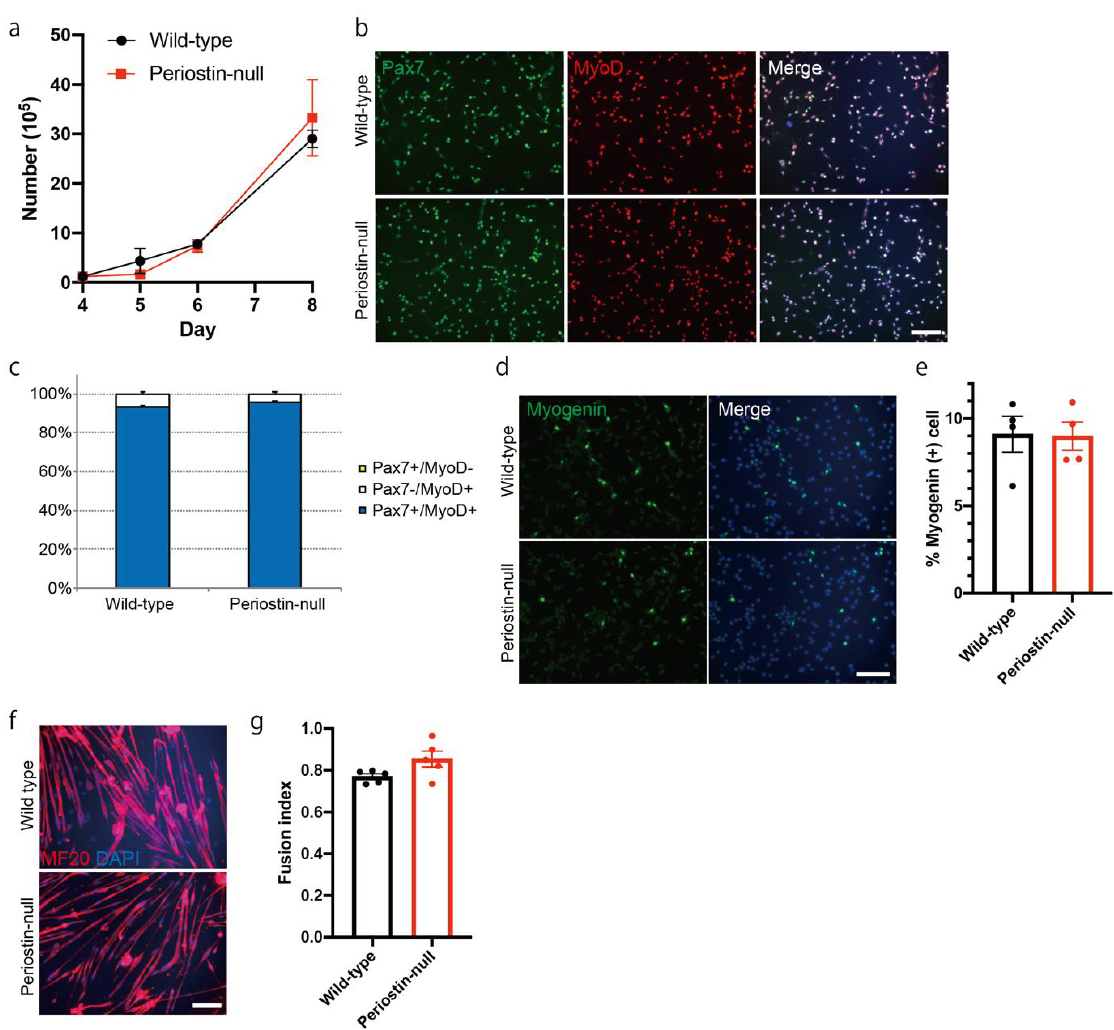
Figure 6. Proliferation and differentiation of muscle progenitor cells are not impaired in periostin-null mice. ( a ) Time- course changes in the number of cultured muscle progenitor cells. n = 4. ( b ) Immunocytochemical analysis of Pax7 and MyoD in muscle progenitor cells from periostin-null mice. Bar: 200 μm. ( c ) Ratio of Pax7+/MyoD-, Pax7-/MyoD+, and Pax7+/MyoD+ cells. n = 4. ( d ) Immunocytochemical analysis of myogenin in muscle progenitor cells from periostin-null mice. Bar: 200 μm. ( e ) Quantitative analysis of myogenin-positive cells. n = 4. ( f ) Immunocytochemical analysis of MF-20 in differentiated muscle progenitor cells from periostin-null mice. Bar: 200 μm. ( g ) Quantitative analysis for the fusion index. n = 5. Error bars indicate SEM.